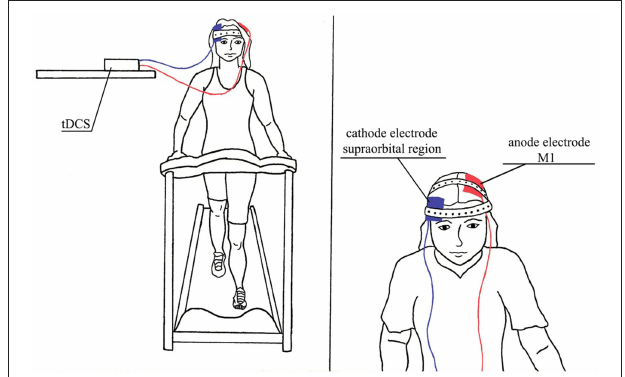
FIGURE 3 | Illustration of interventions in combination, tDCS/AE group which was performed aerobic exercise in combination with tDCS.